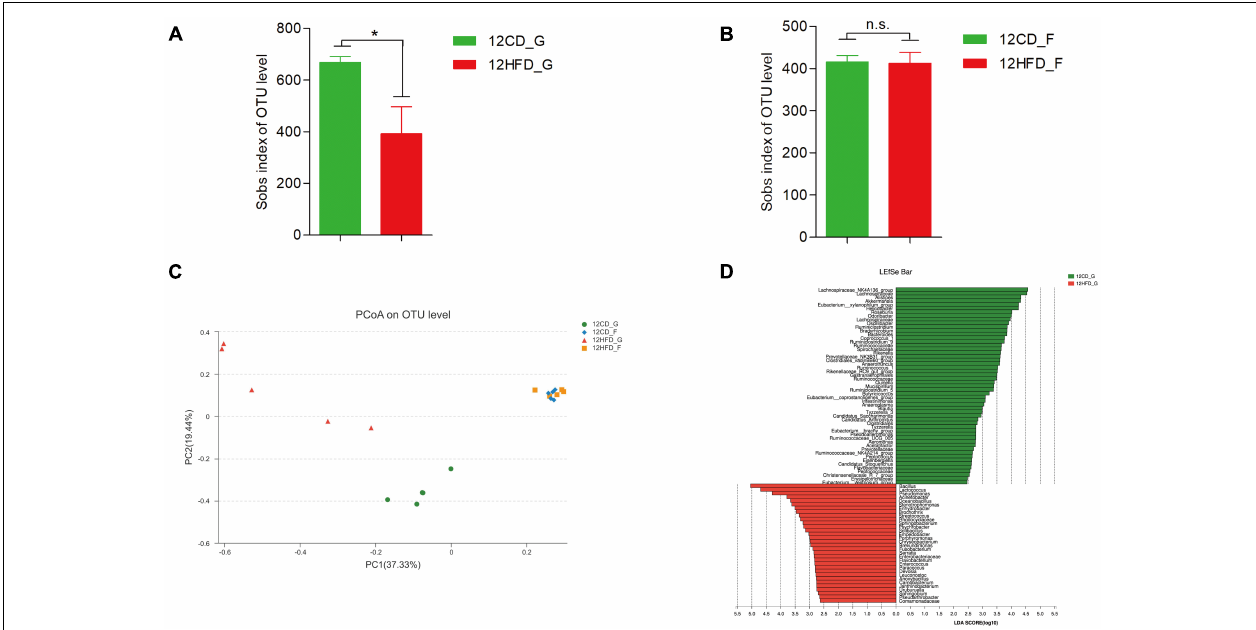
FIGURE 1 | The impact of HFD on the composition of gastric (G) and gut (F) microbiota in mice after 12 weeks ( n = 5 for each group). Decreased alpha diversity in 12HFD_G compared with 12CD_G (A) while no significant difference between 12HFD_F and 12CD_F (B) ( ∗ p < 0.05). Principal coordinate analysis (PCoA) of bacterial beta diversity based on the Bray-Curtis dissimilarity (C) . (D) Linear discriminant analysis (LDA) coupled with effect size measurements identified the most differentially abundant taxa between 12HFD_G and 12CD_G. 12HFD_G enriched taxa were indicated in red while taxa enriched in 12CD_G were represented in green. Only taxa meeting an LDA significant threshold of > 2 were